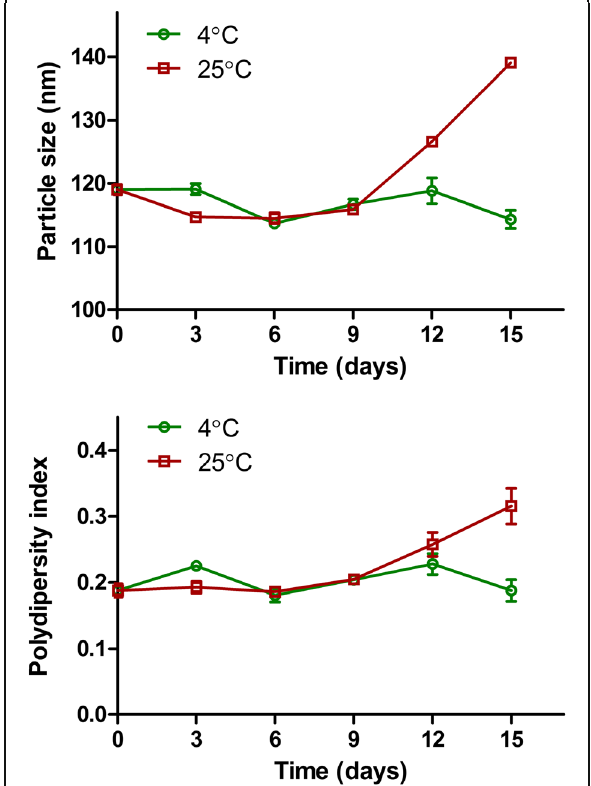
Fig. 3 Stability of DFT-lip at 4 °C and 25 °C in PBS for 15 days determined by particle size and polydispersity